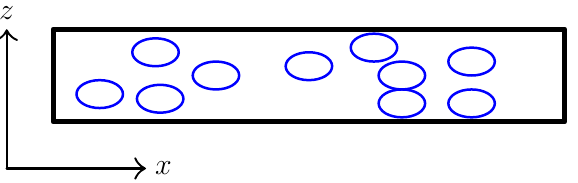
Figure 6. Schematic illustration of superconducting ellipsoid inclusions embedded inside a long thin conductor with dimensions L z (cid:28) L x . It shows that the percolation probability along z is higher than along x -axis if a z / a x > L z / L x